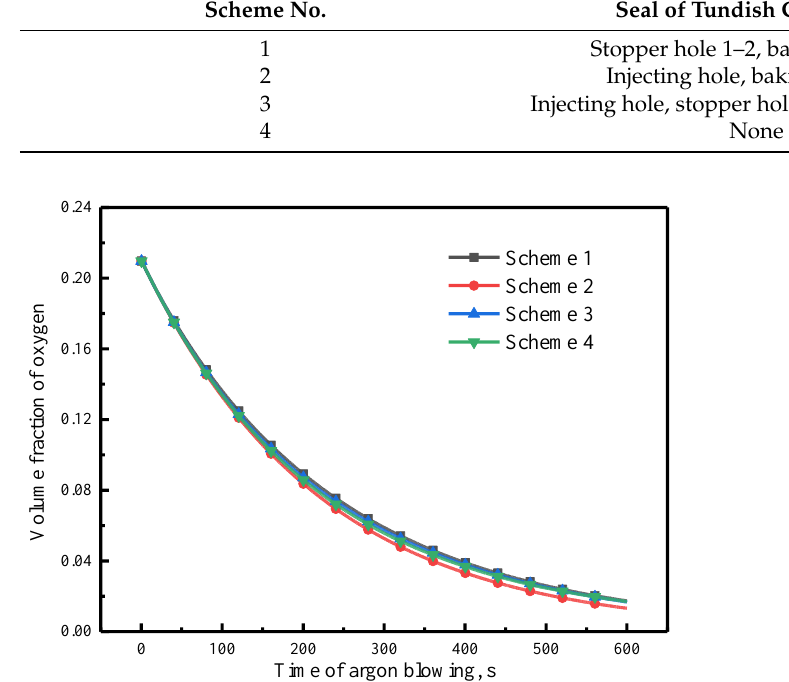
Figure 5. Variation of oxygen volume fraction in tundish for different schemes.